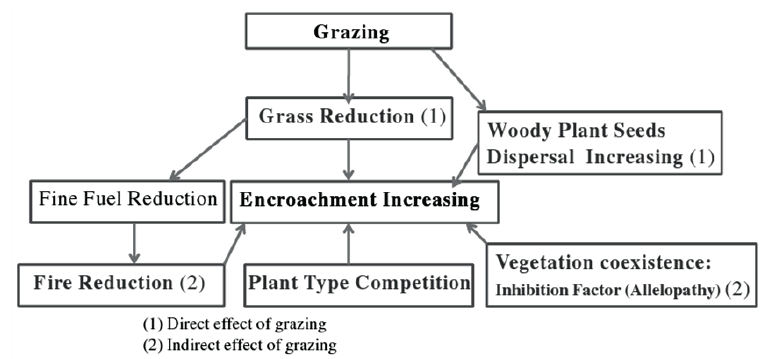
Fig. 3 Conceptual model illustrating the causes of the encroachment.